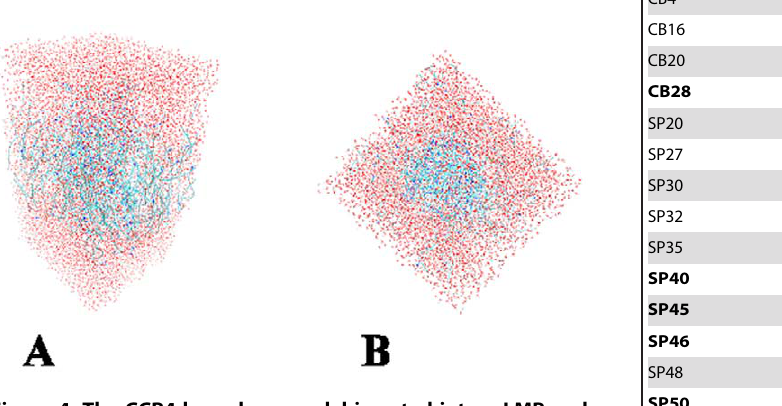
Figure 4. The CCR4 homology model inserted into a LMP and fully solvated. The water atoms (red) form a box around the protein and DPP atoms (blue).